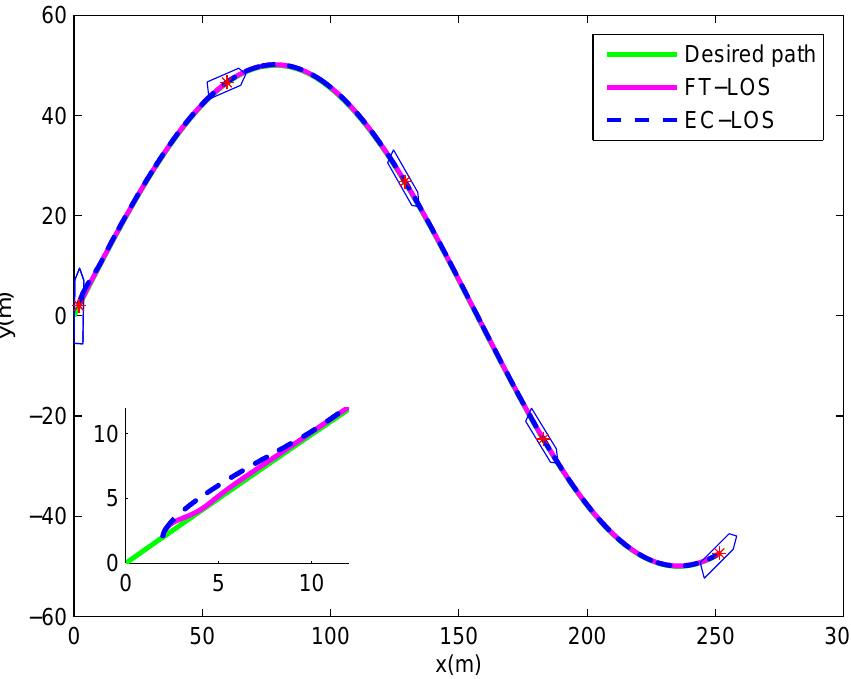
Figure 4. Desired path and actual path of the underactuated MSV.